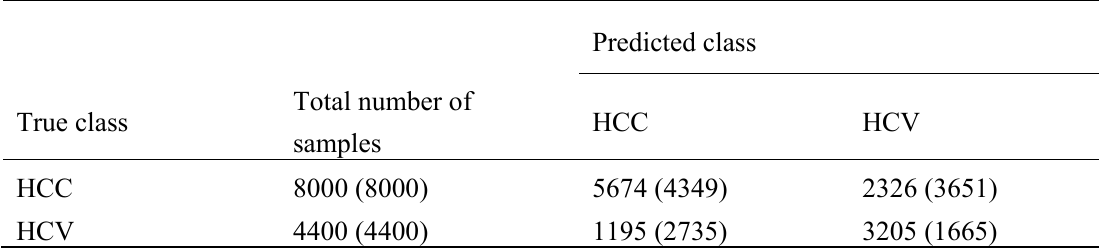
Table 3. Confusion matrix calculated from PLS-DA using 3 serum biomarkers for the HCC (n = 40) and HCV (n = 22) patients using 200 Monte-Carlo cross validation (MCCV) iterations. The numbers in parentheses are the results from permutation analysis.